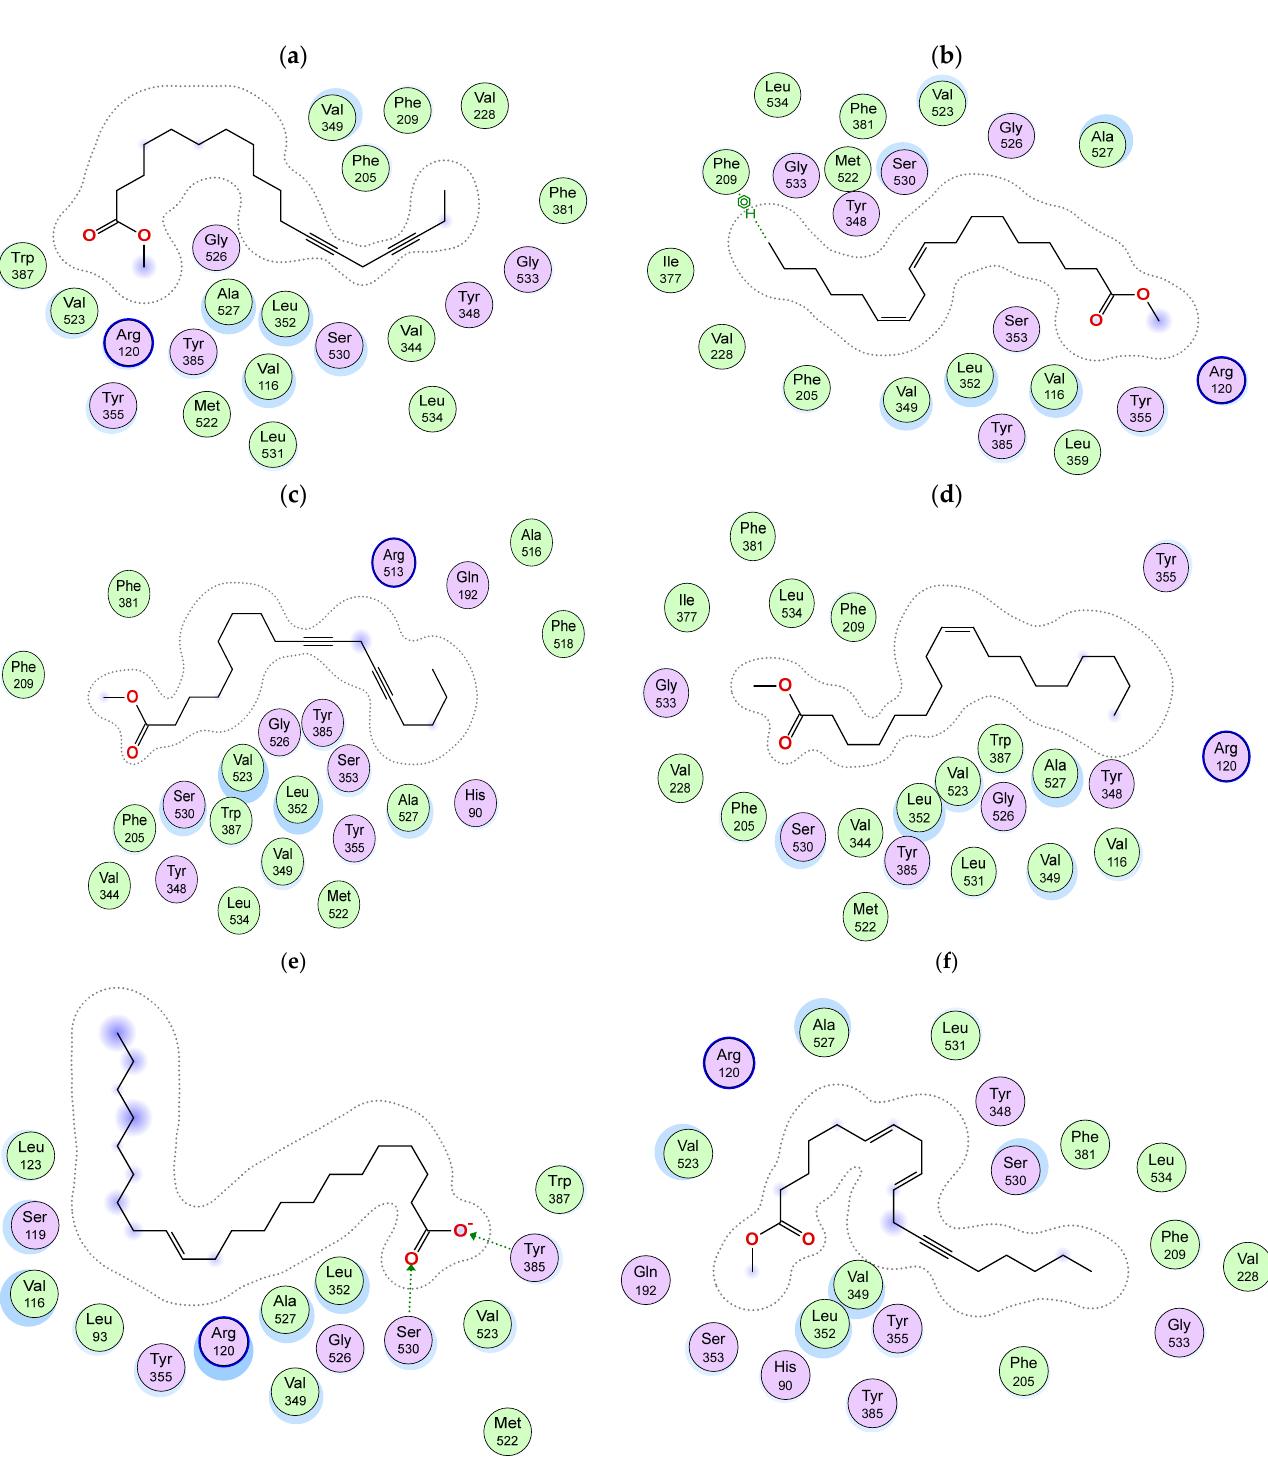
Figure 3. Two-dimensional diagram of the binding interactions of ( a ) metabolite 17, ( b ) metabolite 43, ( c ) metabolite 30, ( d ) metabolite 44, ( e ) metabolite 49 and ( f ) metabolite 32 with the active site residues of COX-2 enzyme. Magenta circles indicate polar amino acids and green circles indicate nonpolar amino acids.